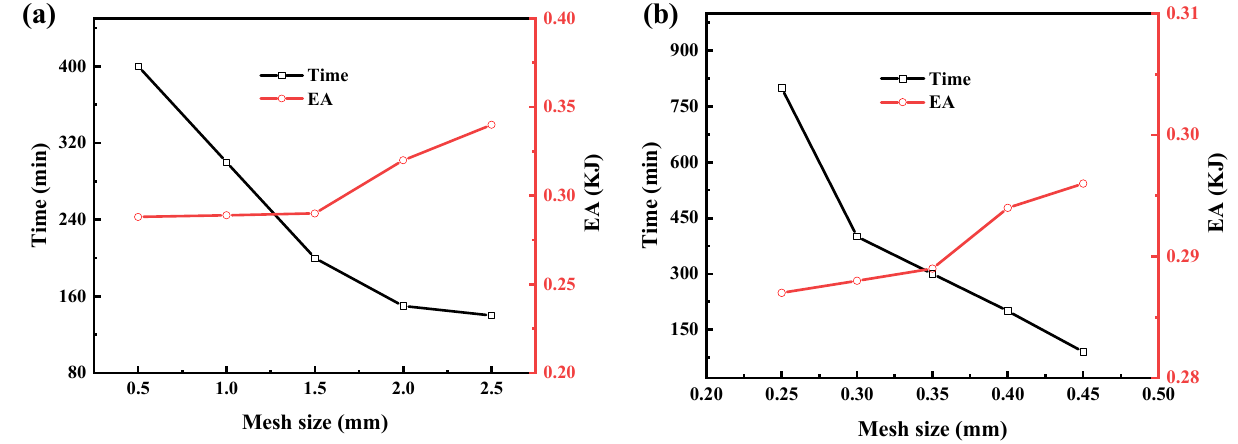
Figure 8. Convergence analysis of the finite element model: ( a ) convergence analysis of thin-walled aluminum tubes, ( b ) convergence analysis of dotted structure.